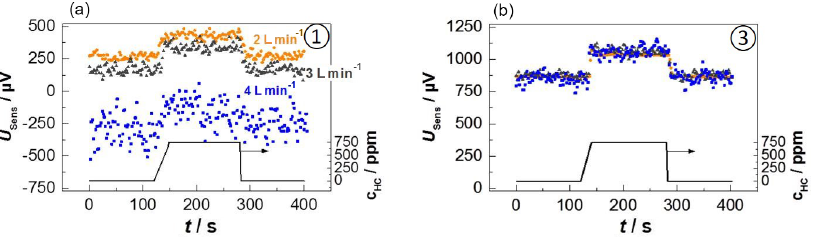
Figure 7. Sensor raw signal for stepwise HC admixture (750ppm) in different flow conditions: variable flow rate (2, 3, and 4Lmin − 1 ) at position (1) (a) and at position (3) (b)